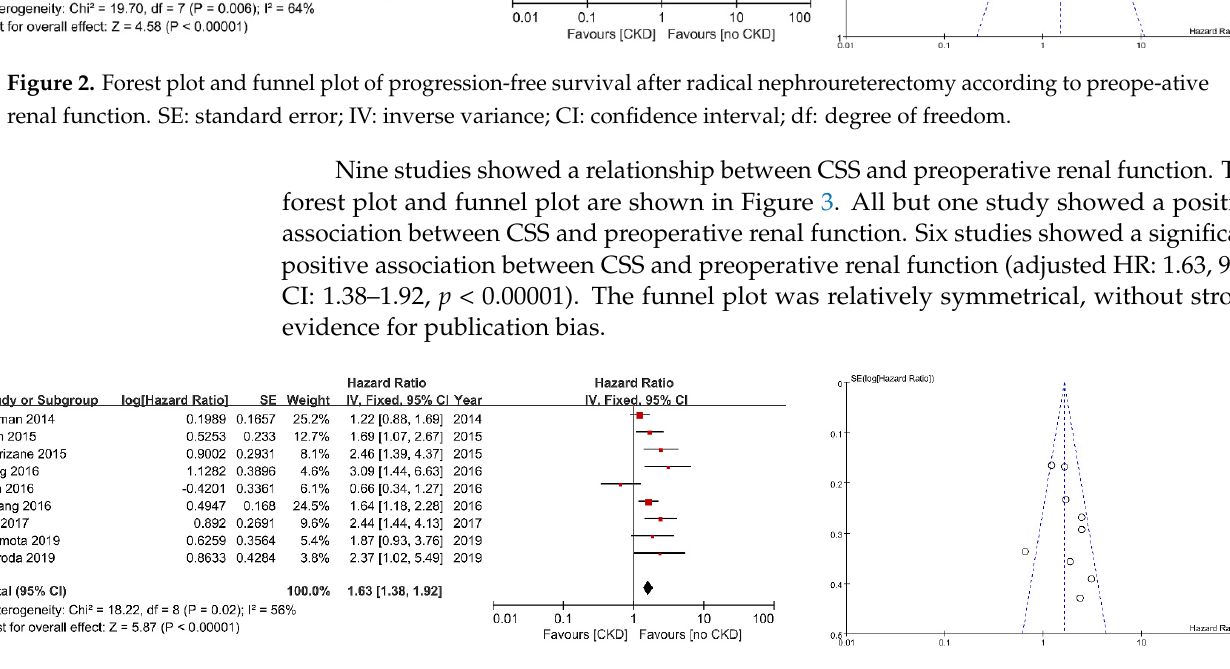
Figure 3. Forest plot and funnel plot of cancer-specific survival after radical nephroureterectomy according to preparative renal function.